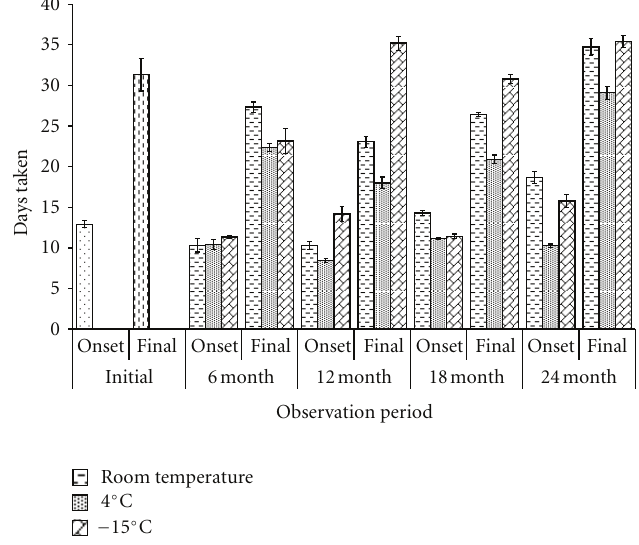
Figure 1: Storage e ff ect on onset and final seed germination in Swertia chirayita ( vertical bars indicate the standard deviation ).